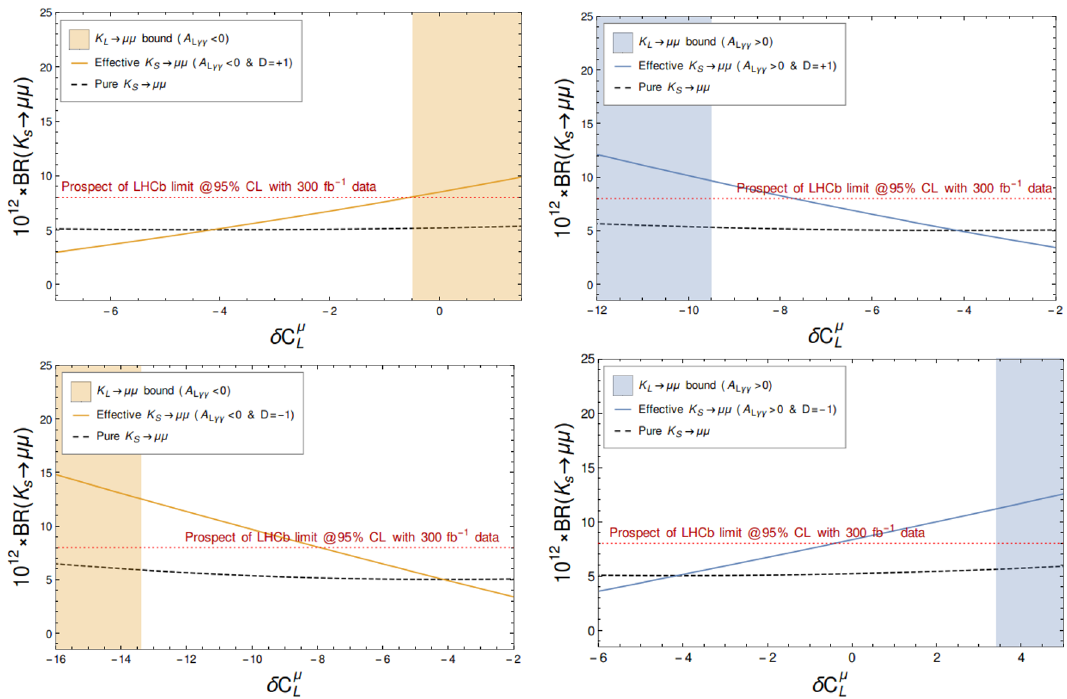
Figure 5 . The impact of the interference of K L → µ ¯ µ on the effective branching fraction of K S → µ ¯ µ . The left and the right panels correspond to negative and positive signs for A Lγγ , respectively. The upper and lower panels correspond to dilution factor D = +1 and D = − 1 ,